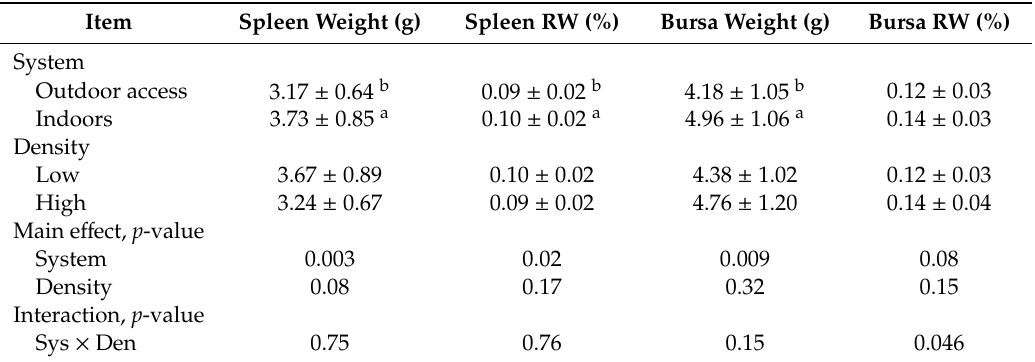
Table 7. LS Means of the effects of system, density and week of age on lymphoid organs of commercial-line broilers 1